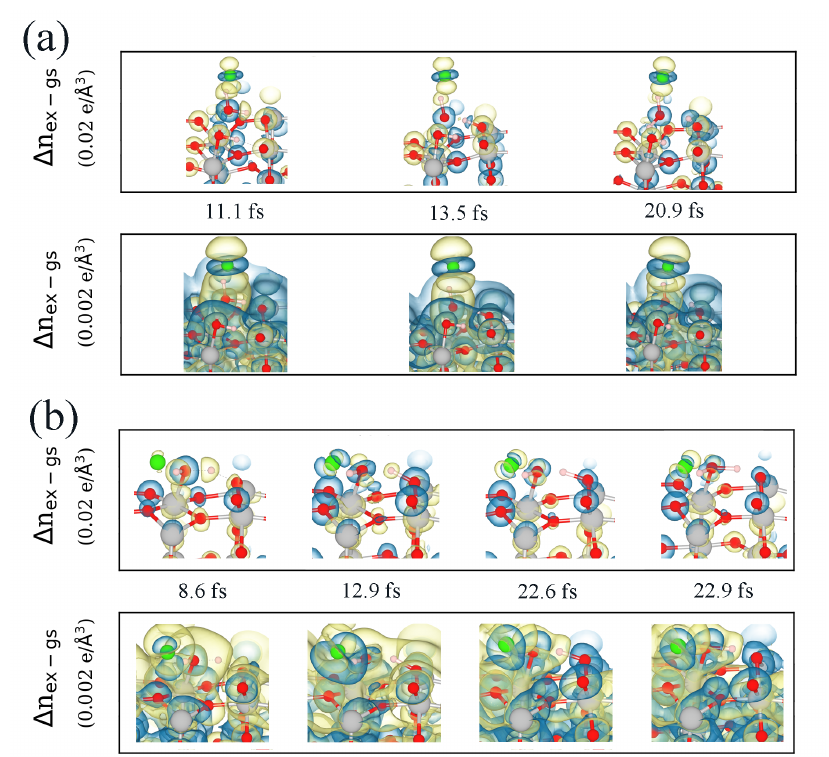
Figure 4. The difference between the total charge densities of the excited states and the ground states ( ∆ n ex − gs ) of the surface models at different time steps during the photoexcitation. The geometric configurations are based on Figure 3 for ( a , b ), respectively. The ∆ n ex − gs are expressed by two isosurfaces with value 0.02 (top panels) and 0.002 (bottom panels) e/Å 3 , where transparent yellow and blue signify volume of the ∆ n ex − gs accumulation and depletion,